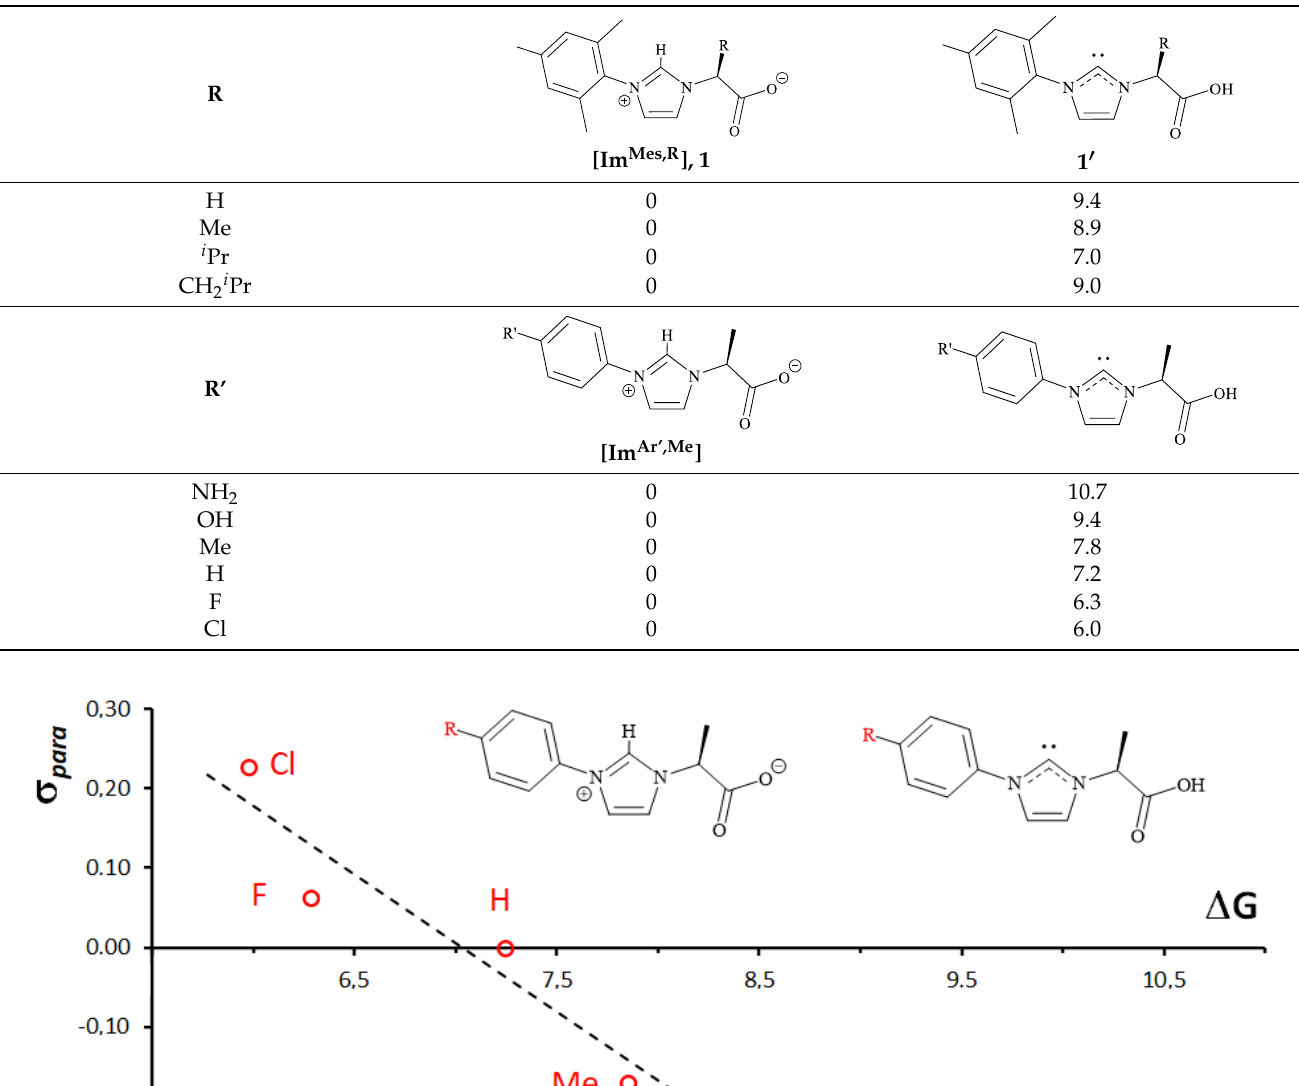
R Table 4. Relative energies ( ∆ G, kcal · mol − 1 ) of [Im Mes,R ], 1 , and [Im Ar’,Me ] and their carbene isomers. Table 4. Relative energies (Δ G, kcal·mol −1 ) of [Im Mes,R ], 1 , and [Im Ar’,Me ] and their carbene isomers. Table 4. Relative energies (Δ G, kcal·mol −1 ) of [Im Mes,R ], 1 , and [Im Ar’,Me ] and their carbene isomers. Table 4. Relative energies (Δ G, kcal·mol −1 ) of [Im Mes,R ], 1 , and [Im Ar’,Me ] and their carbene isomers. Table 4. Relative energies (Δ G, kcal·mol −1 ) of [Im Mes,R ], 1 , and [Im Ar’,Me ] and their carbene isomers.